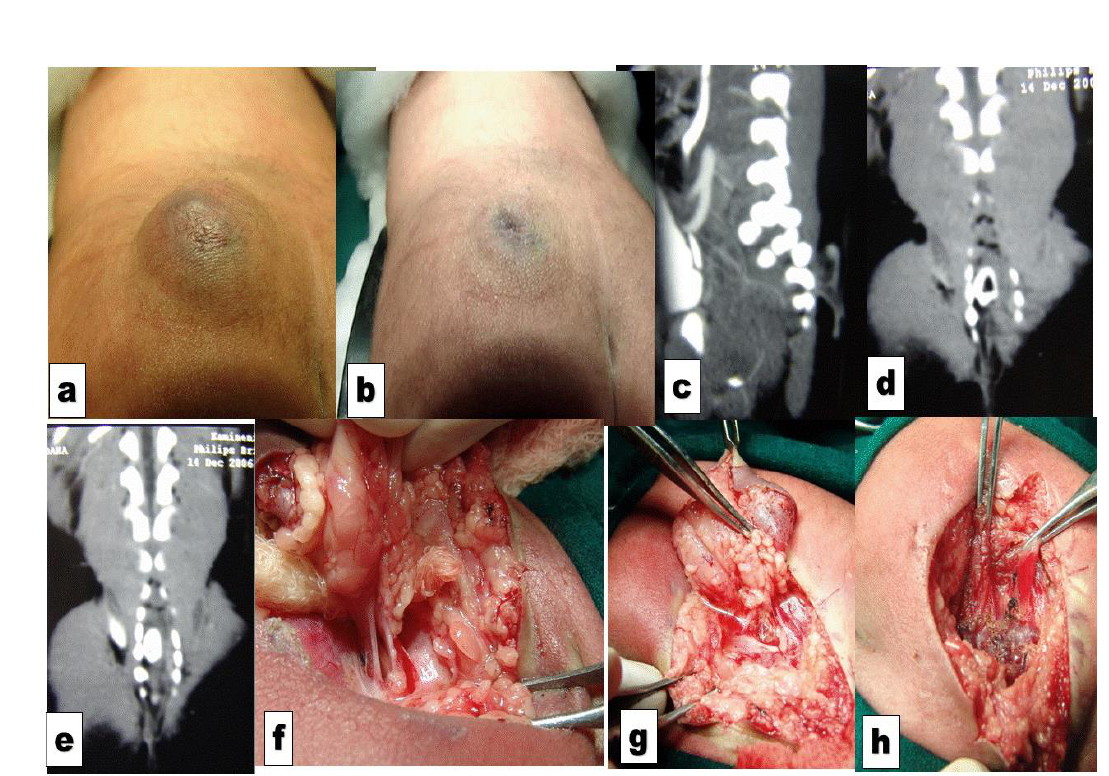
Figure 1: (a) Upper gluteal non tender soft cystic fluctuant reducible mass. (b) Collapsed on pressure. (c) Sagital view of CT scan showing the meningomyelocele. (d) Spindle shaped widening of interpeduncular space of sacrum with a defect in the bone laterally. (e) Coronal CT showing widened spinal canal with body fur. (f) Neural material seen with the margin of the defect. (g) Exteriorized neural placode in progress. (h) Gluteal flap to cover the dual defect that is closed